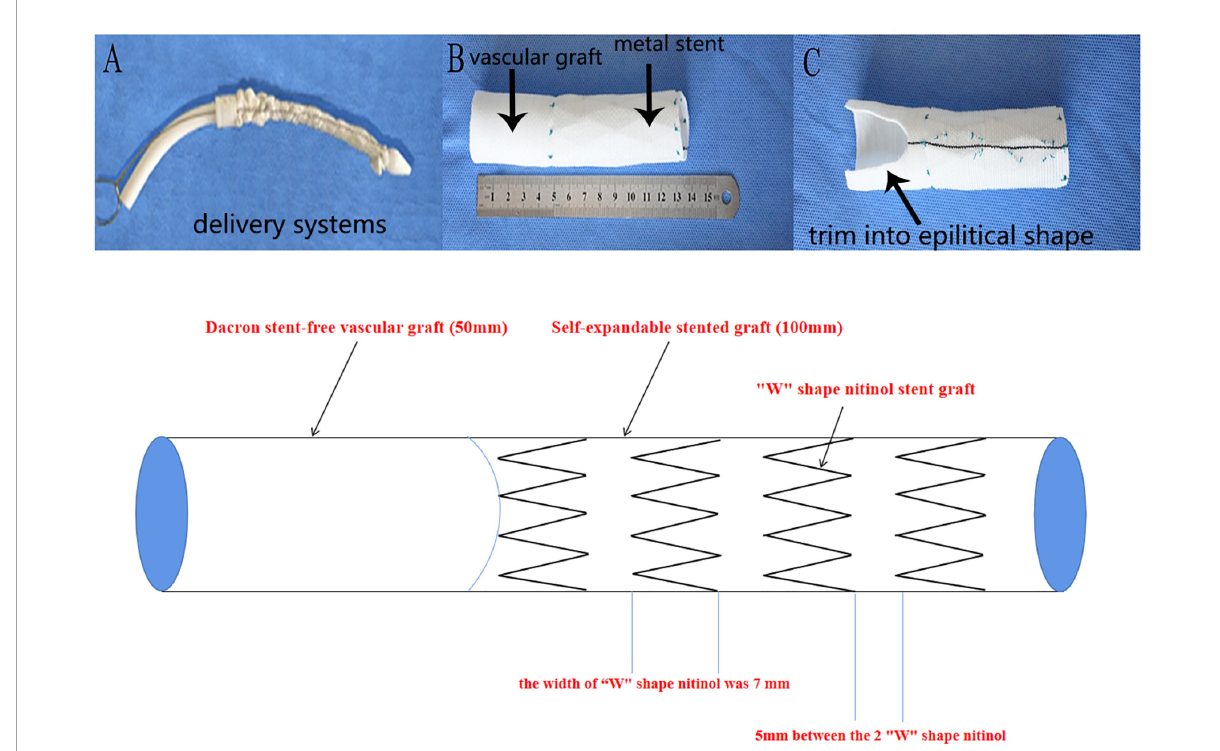
FIGURE1 Self design stent graft. (A) : Compacted modified stent graft with the delivery system before implantation. (B) : Stent graft in expanded state: a distal 10 cm self-expandable nitinol stent graft and the proximal 50-mm dacron stent-free vascular graft. (C) : Example demonstration of the trimmed vascular graft used for aortic arch inclusion technique. (D) : Sketch of the self-designed stent graft: the stent graft was mainly composed of “W” shape nitinol material and dacron stent-free vascular graft.